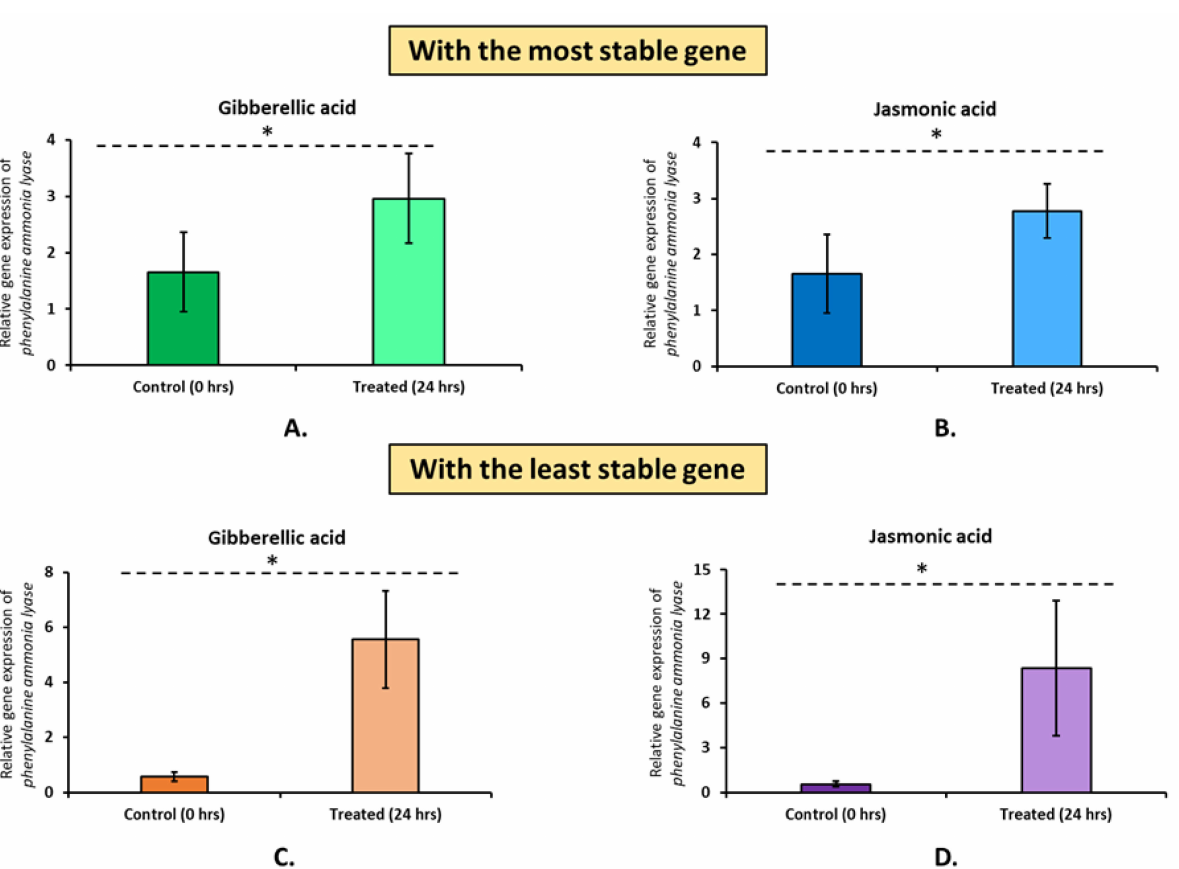
Figure 6. Relative expression level of phenylalanine ammonia lyase (PAL) under gibberellic acid stress ( A , C ) and jasmonic acid stress ( B , D ). Relative gene expression before elicitor treatment (Control) and after treatment (the most stable and the least stable gene) were compared, and normalization was performed with EF-1 α | GAPDH (the most stable gene) and HLH71 (the least stable gene). The relative gene expression between the control and elicitor-stressed samples was compared by Student’s t -test, “*” on the vertical bars indicating a significant difference at p <